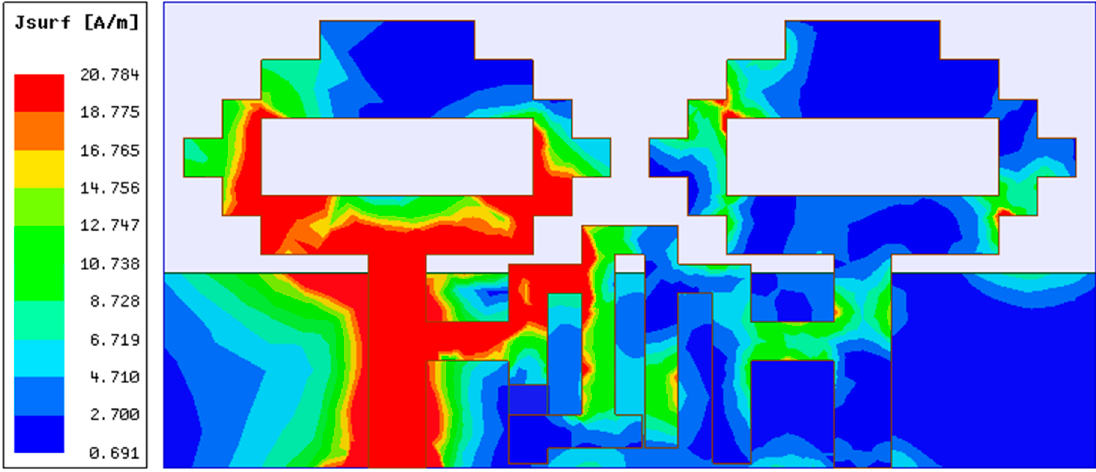
Figure 17. Two-element MIMO antenna surface current distribution at 1.77 GHz.